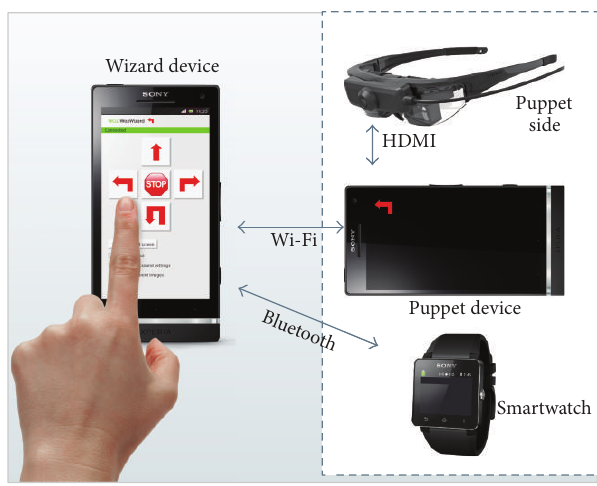
Figure 1: The WozARd architectural